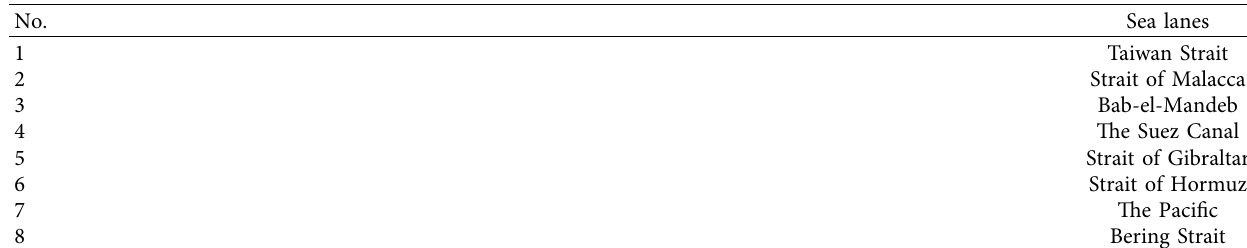
Table 4: Main sea